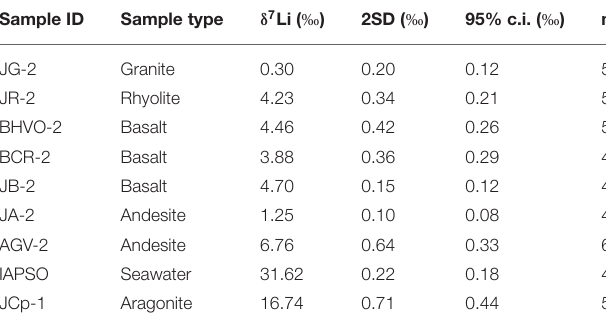
TABLE 4 | Li isotopic compositions of standard reference